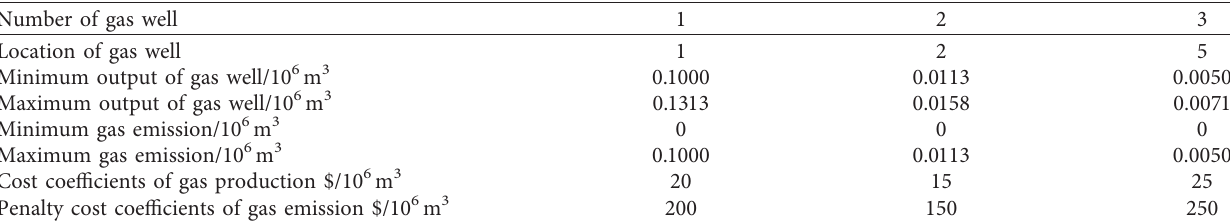
Table 2: Parameters related to the gas well.